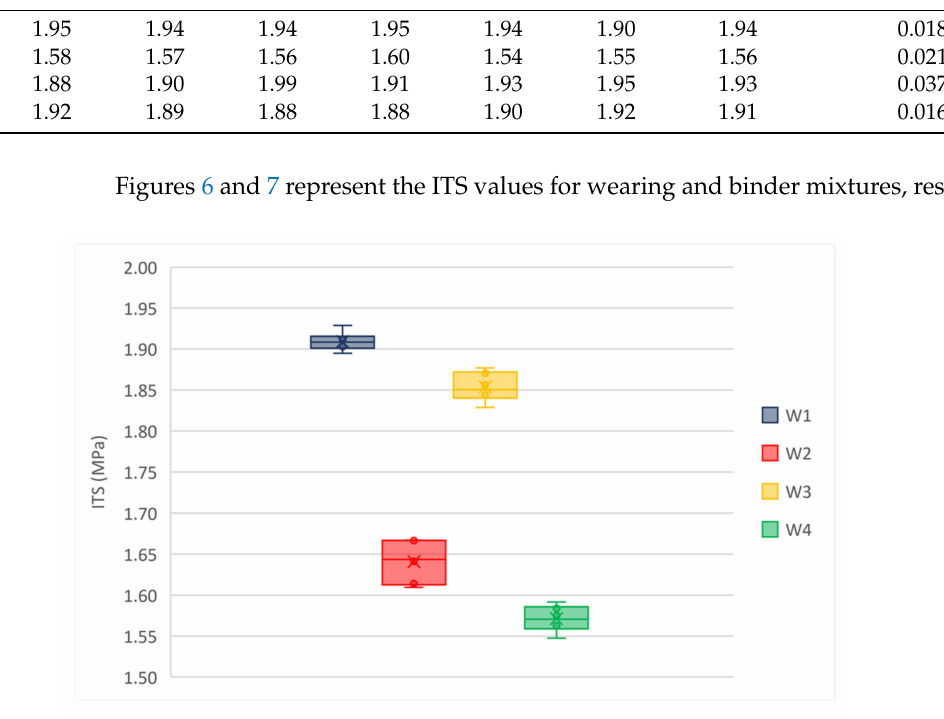
Figure 6. Average ITS of wearing mixtures, T = 25 ◦